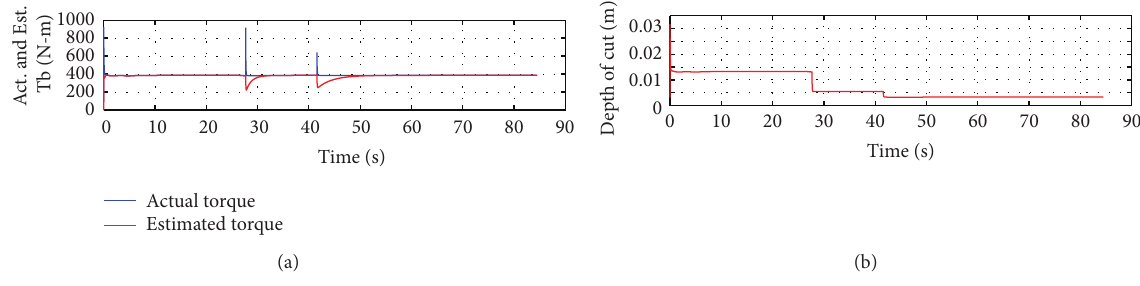
̂𝑇(𝑡) (𝑡) (b). (a); depth of cut 𝑑 cut